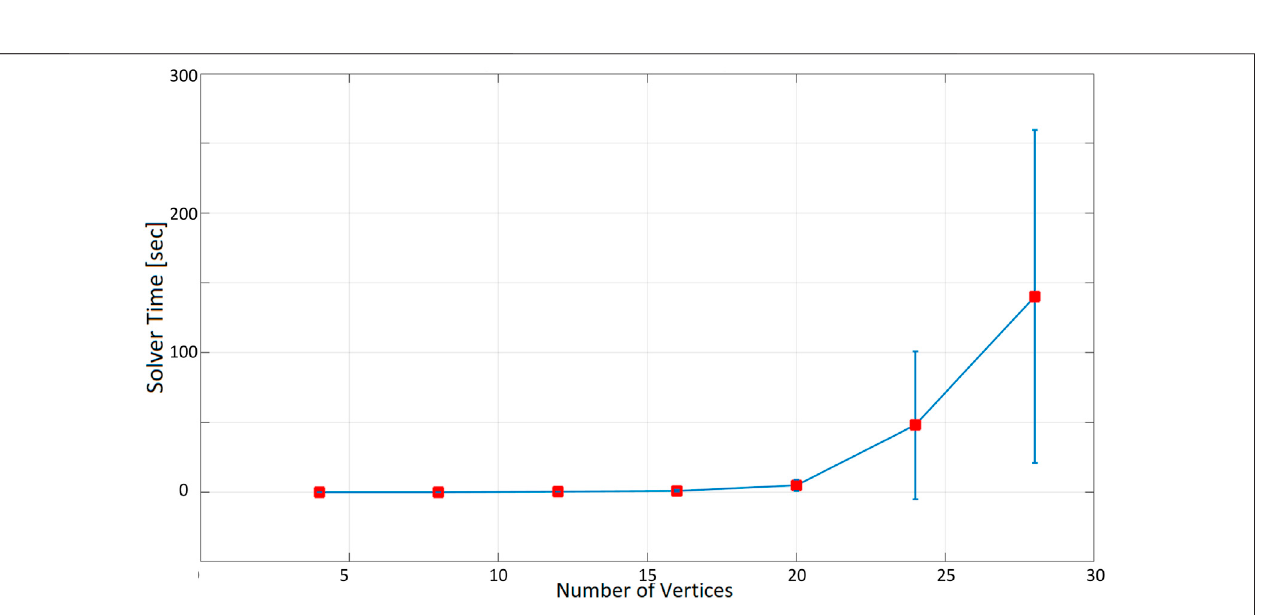
Frontiers in Robotics and AI |